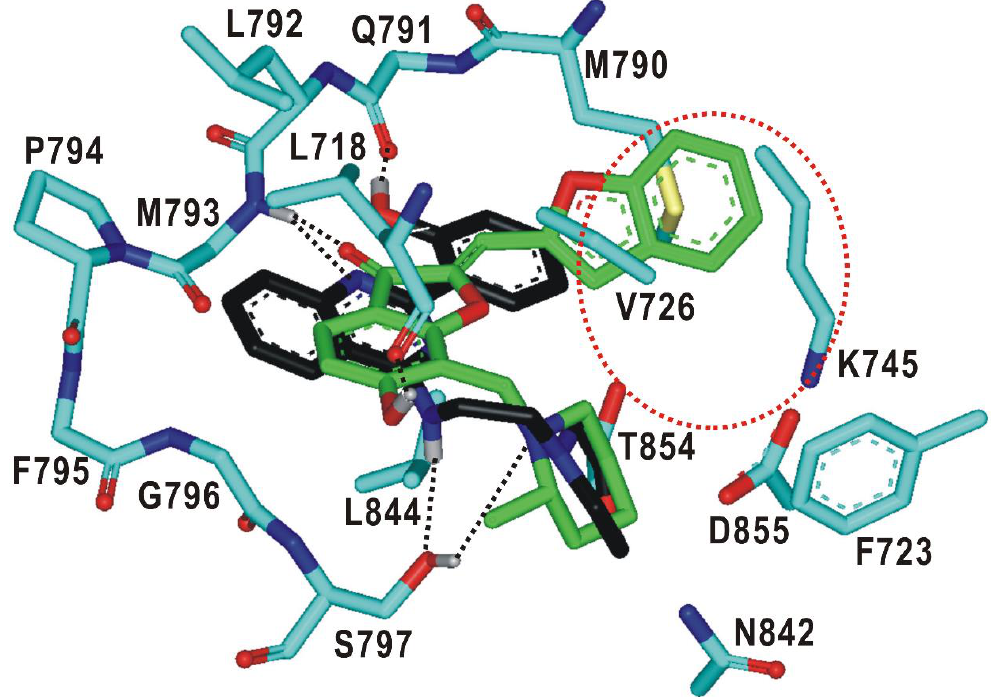
Figure 5. Detailed interaction patterns of 1 and 2 in the ATP-binding site of the d746-750 / T790M / C797S mutant EGFR. Carbon atoms of 1 and 2 are colored in green and black, respectively. Hydrogen bond interactions are represented with dotted lines. The red dotted circle indicates a peripheral binding pocket.